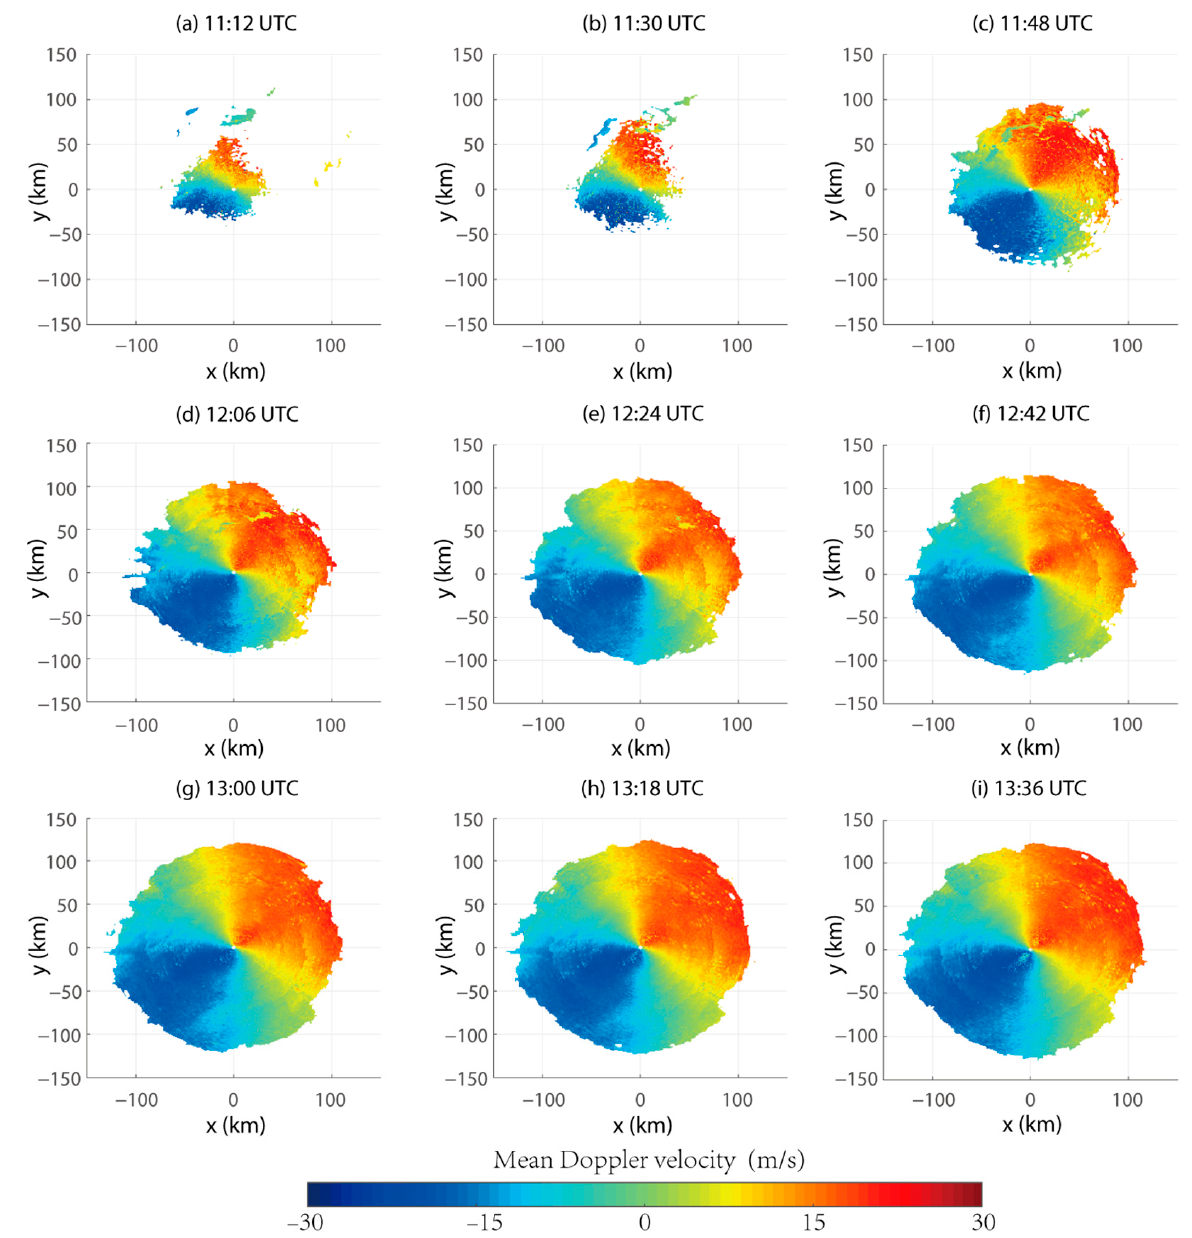
Figure 7. Mean Doppler velocity for 2.4 h from the CINRAD/SA, 2 May 2021. ( a – i ) Continuous observations from the CINRAD/SA at 12 min intervals from 11:12 to 13:36. The horizontal and vertical coordinates are, respectively, the ranges (km) in the west–east direction and the south–north direc- tion.